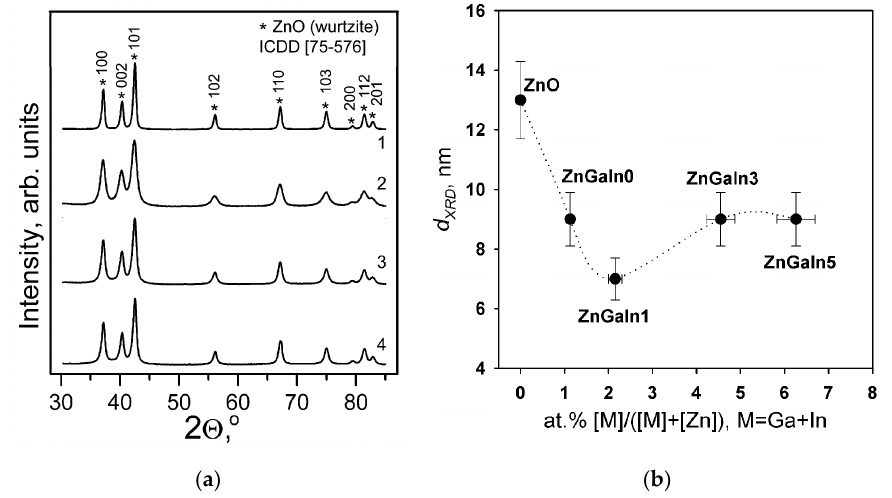
Figure 1. ( a ) XRD patterns of Zn(Ga, In) powders: (1) ZnGaIn0, (2) ZnGaIn1, (3) ZnGaIn3, (4) ZnGaIn5; ( b ) The dependence of ZnO grain size d XRD calculated from the broadening of the (002) XRD peak on donor impurity content.